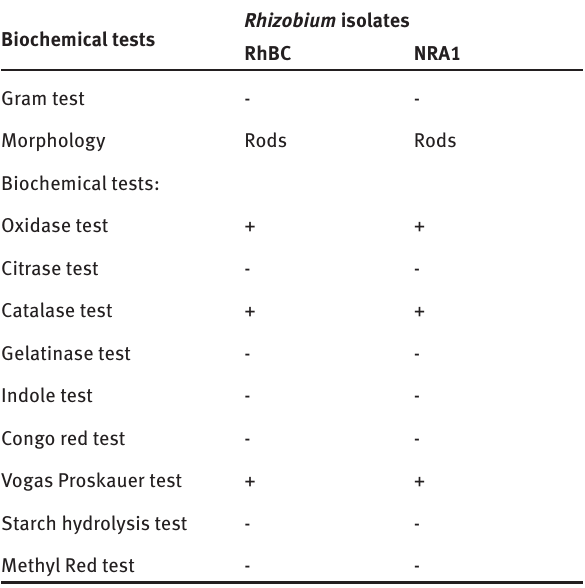
Table 2: Morphological and biochemical characterization of